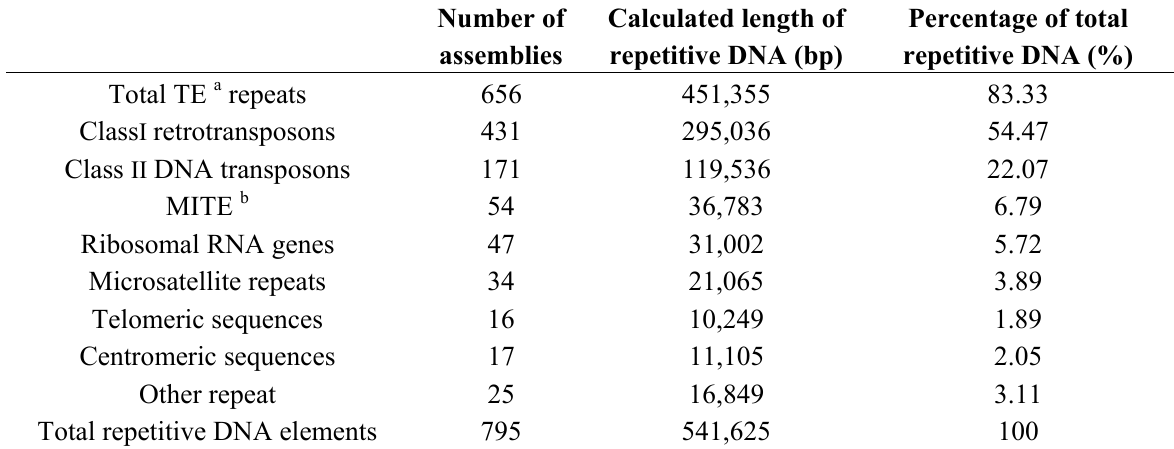
Table 3. Summary of repetitive DNA